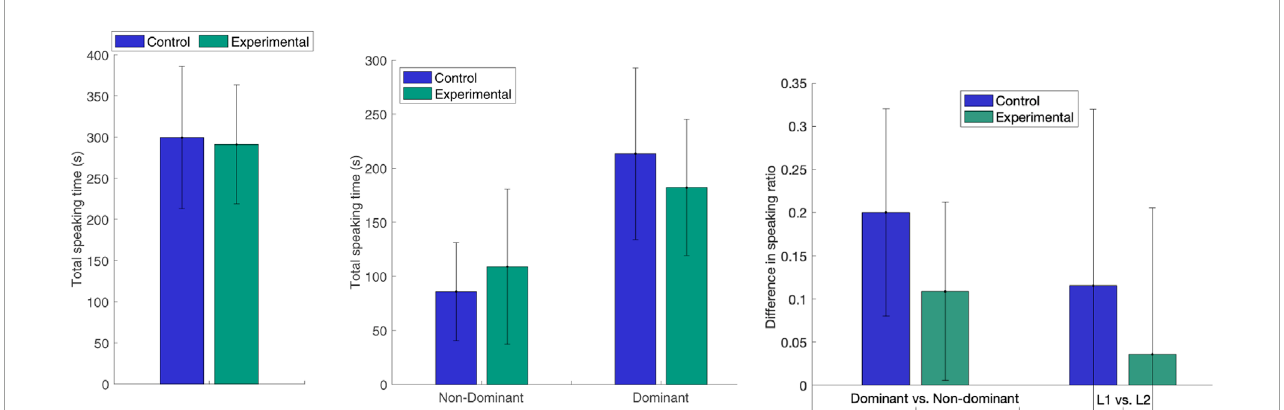
FIGURE 2 Left: Average total speaking time for both speakers. Middle: Average total speaking time for the dominant and non-dominant speaker in the pair. Right: Average difference in speaking ratio Δ R between the dominant and non-dominant speaker or the L1 and L2 speaker in each pair.